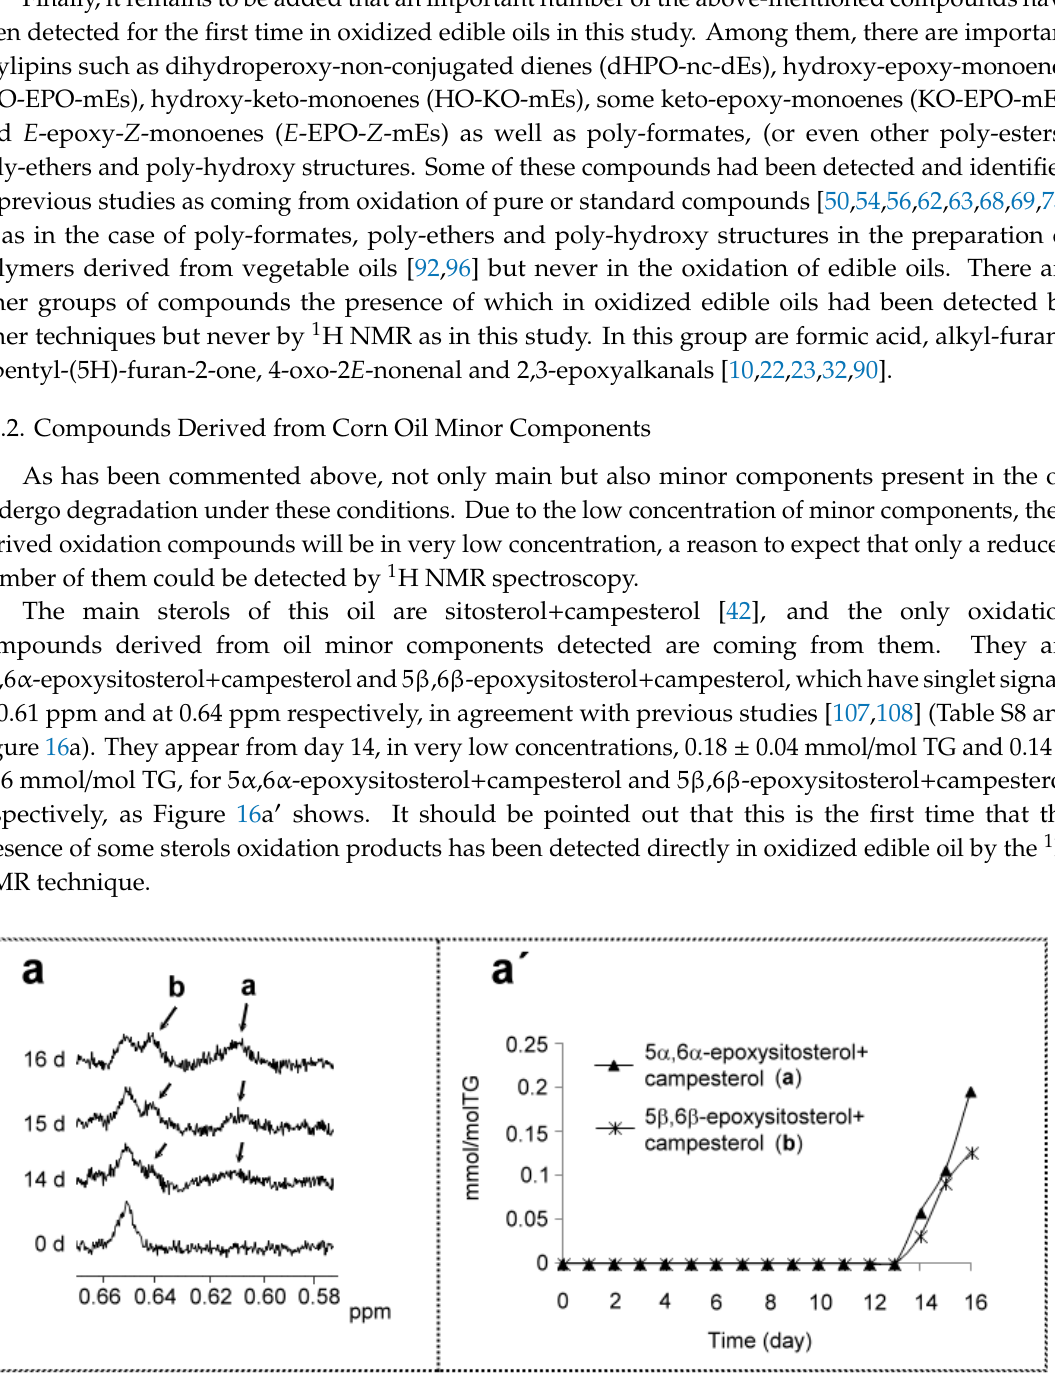
Figure 16. ( a ) Enlargement of region of the 1 H NMR spectra region in which the signals of 5 α ,6 α -epoxysitosterol + campesterol and 5 β ,6 β -epoxysitosterol + campesterol appear. ( a´ ) Evolution of their concentration, expressed as mmol / mol TG versus time given in days.